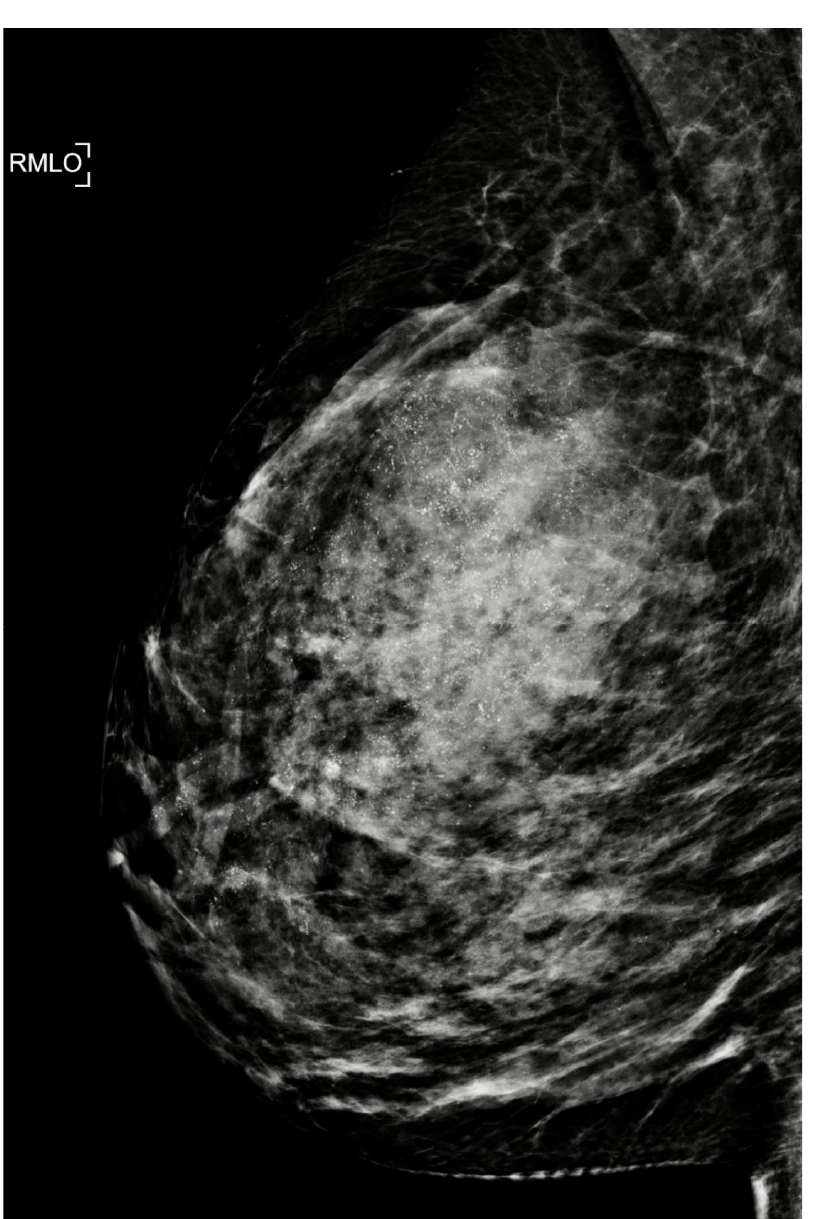
Figure 3. Right oblique mammogram showing extensive micro-calcifications (120 mm) associated with high grade DCIS (ER-negative/HER2-positive) and invasive breast cancer (triple-positive) in a 37-year-old patient. The final histology showed pCR and no viable residual DCIS after NST (chemotherapy and HER2 antibodies). The patient had nipple-sparing mastectomy and immediate reconstruction with targeted axillary dissection. Preservation of the nipple was facilitated by the eradication of extensive DCIS with NST.